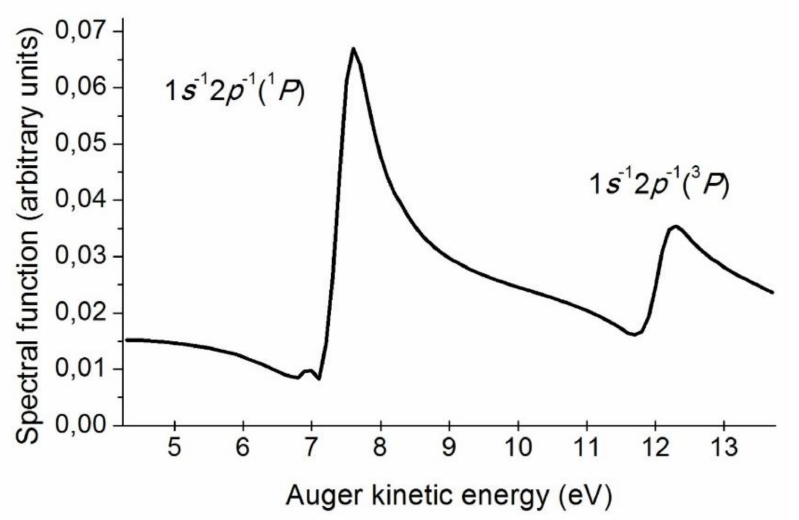
(cid:0) 3 (cid:1) (cid:0) 2 (cid:1) S S 3 s into two